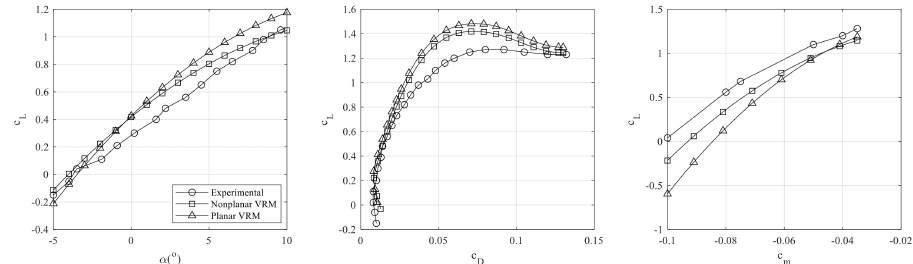
Figure 8. Comparison of computation and experimental longitudinal aerodynamic coe ffi